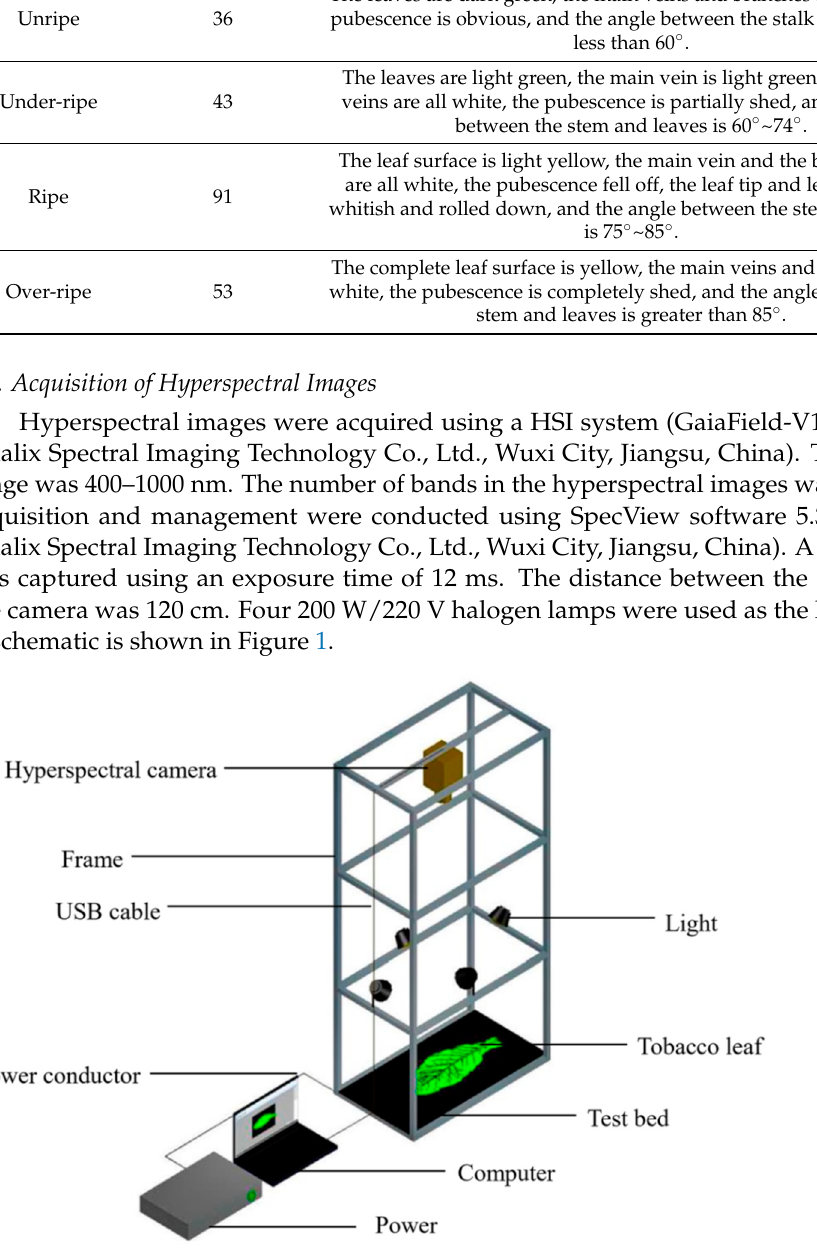
Figure 1. Hyperspectral image acquisition of tobacco leaves.